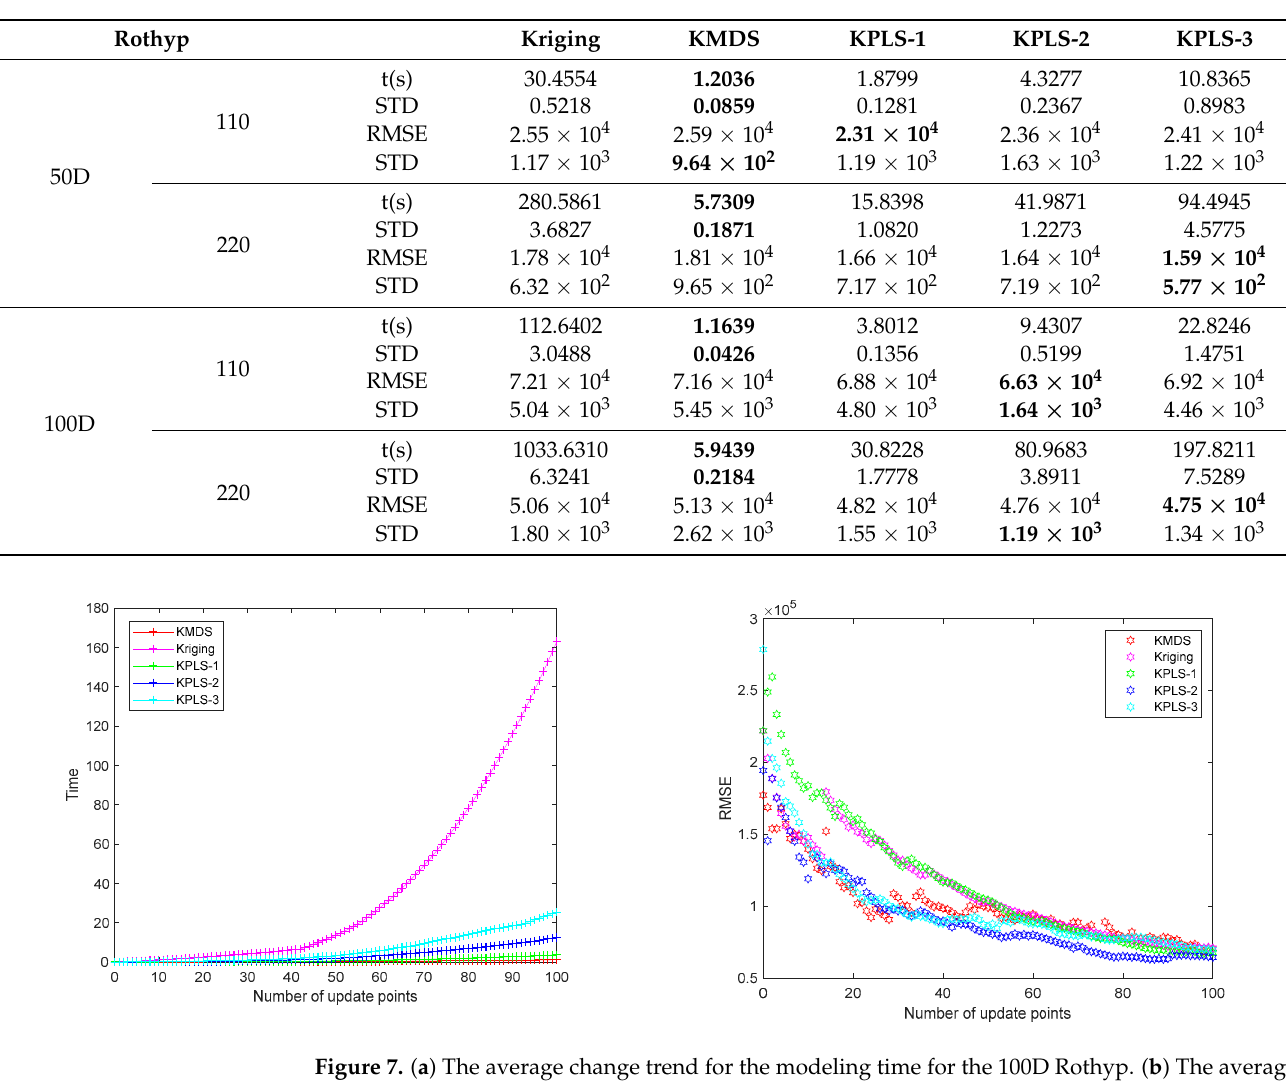
Figure 7. ( a ) The average change trend for the modeling time for the 100D Rothyp. ( b ) The average change trend for RMSE for the 100D Rothyp.